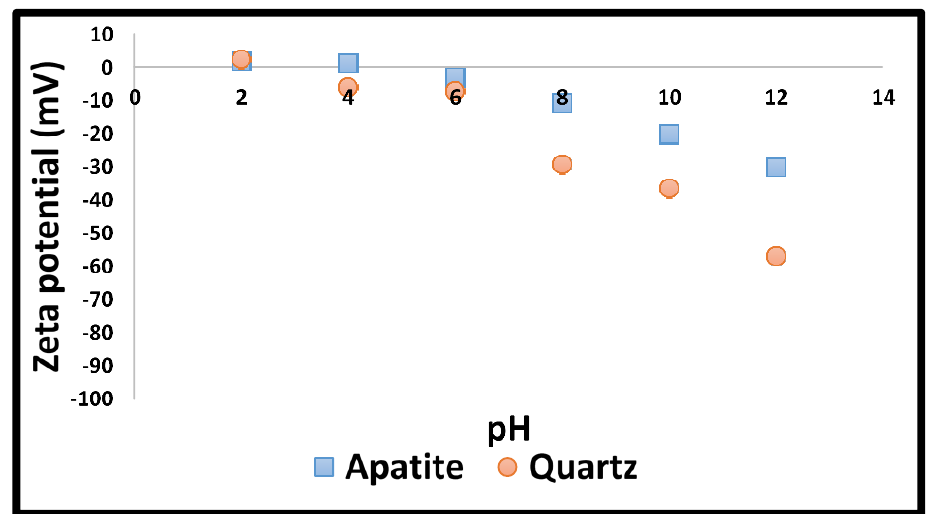
Figure 6. Zeta potential of apatite and quartz dispersions as a function of pH.